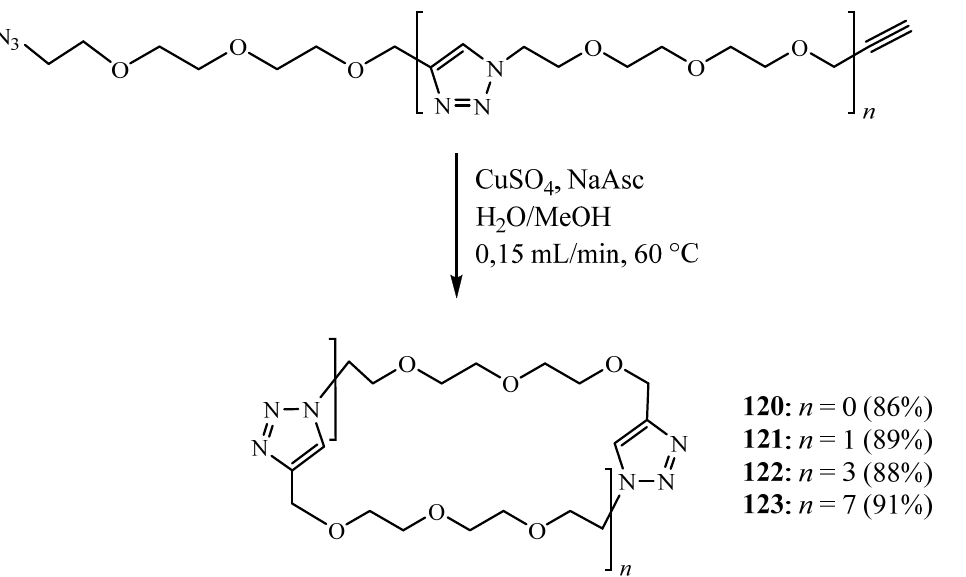
Figure 29. Structures of bitriazolic macrocycles 120 − 123 with different size cavities. (Reprinted with permission from ref. [49]. Copyright 2009 John Wiley and Sons).